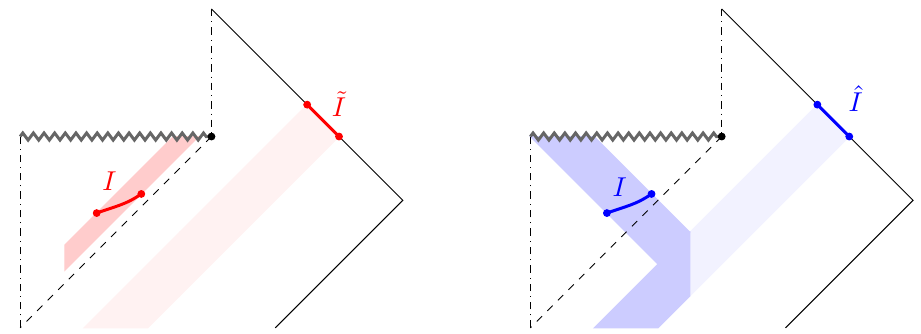
Figure 2 . On the left the outgoing modes inside the horizon that pass through the island and their map onto ˜ I ⊂ I + via the involution ˜ u → u or U → − U . On the right, we illustrate the reflected modes that pass through the island I and their map onto ˆ I ⊂ I + via v → u